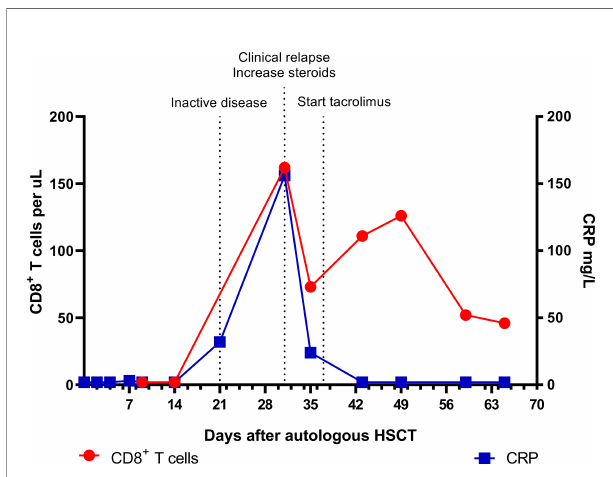
FIGURE 1 | Absolute CD8 + T cell numbers and CRP levels in the early phase after autologous HSCT. Inactive disease status on day 21 was based on a normal F-18-FDG PET scan and absence of symptoms. CRP, C-reactive protein; HSCT, hematopoietic stem cell transplantation; PET, positron emission